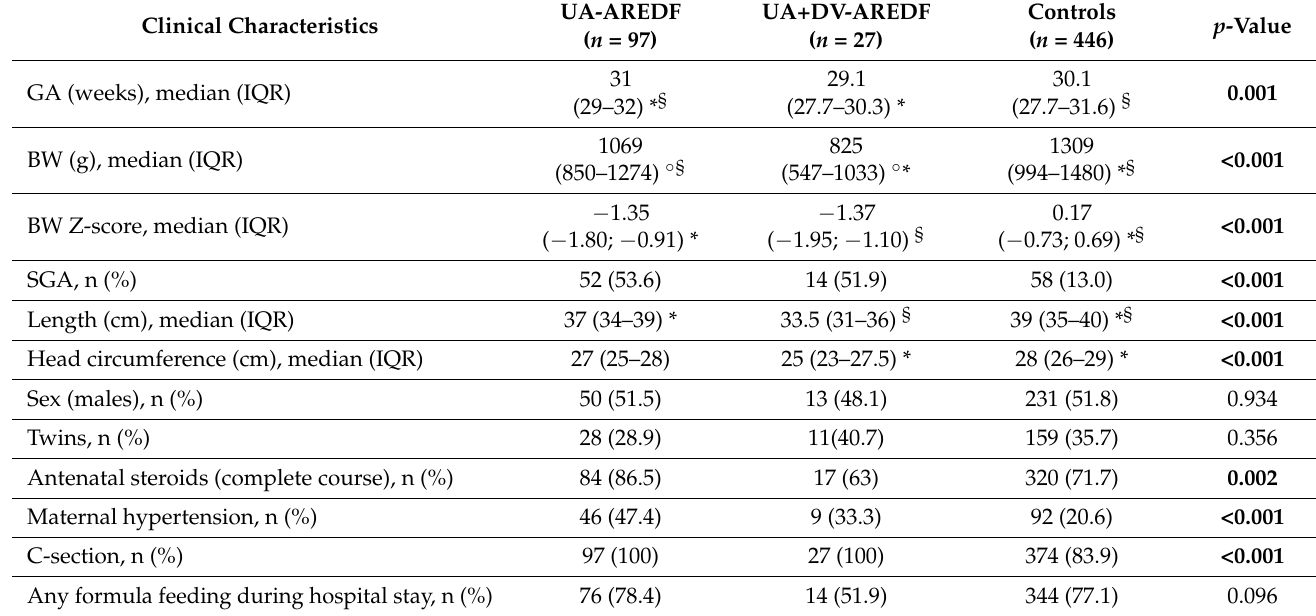
Table 1. Clinical characteristics in infants with UA-AREDF, UA+DV-AREDF and controls. Significant between-group comparisons are highlighted in bold. Abbreviations: BW: birth weight; GA: gesta- tional age; IQR: interquartile range; SGA: small for gestational age; UA-AREDF: absent or reversed end diastolic flow in the umbilical artery only; UA+DV-AREDF: absent or reversed end diastolic flow in the umbilical artery and in the ductus